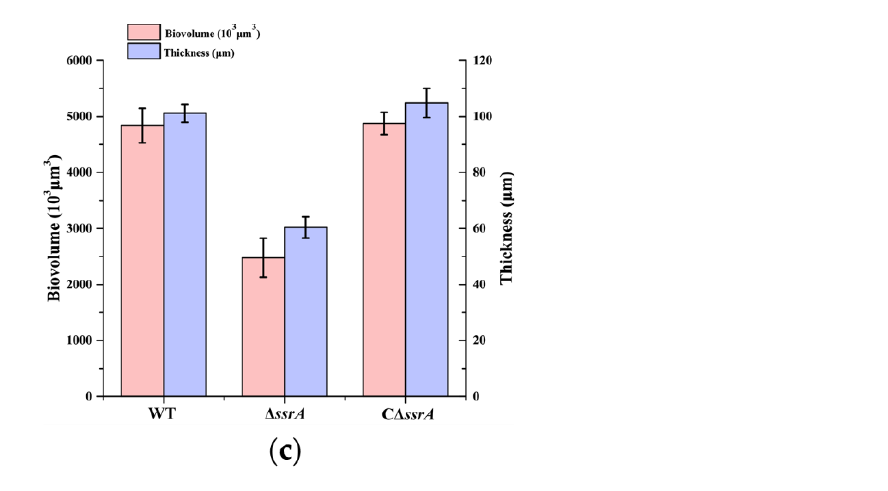
Figure 1. Comparison of the biofilm formation among WT, TM, and C ∆ ssrA . ( a ) The WT, TM, and C ∆ ssrA strains were grown in the MSgg agar plates for 3 days (left) and in 24-well microtiter plates supplied with the LBMG liquid medium for 48 h (right), and biofilms produced by the strains were observed. The images shown are the representatives of three independent experiments. The two scale bars both represent 5 mm. ( b ) Biofilms formed in the microtiter plates described in (A) were stained with STYO ® 9 and investigated using CLSM. Images of cells attached to the surface were shown in Lane 1. The confocal series were reconstructed through the software IMARIS and a representative image (left) with virtual shadow projection (right) is shown for each strain in Lane 2. The three-dimensional (3D) models of biofilms formed by these three strains are shown in Lane 3. The scale bars represent 200 µ m and 50 µ m, from left to right, respectively. ( c ) Quantification of the thickness and biovolume of the submerged biofilms produced by WT, TM, and C ∆ ssrA . The biovolume (purple) and the thickness (pink) were calculated as average ± S.D. of six image series for each strain.